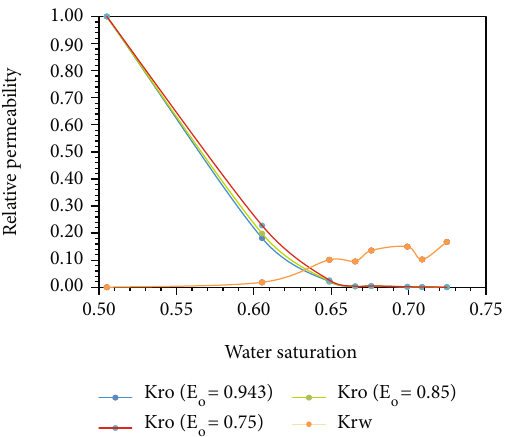
Figure 7: E ff ect of the non-linear fl ow coe ffi cient on oil-water relative permeability.